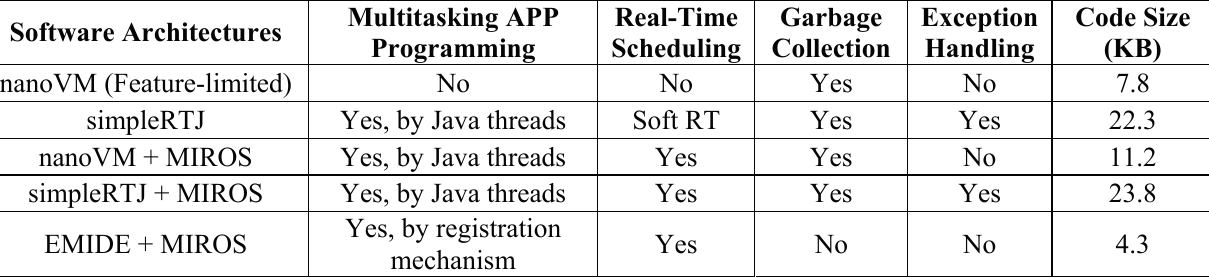
Table 9. Features of the different software